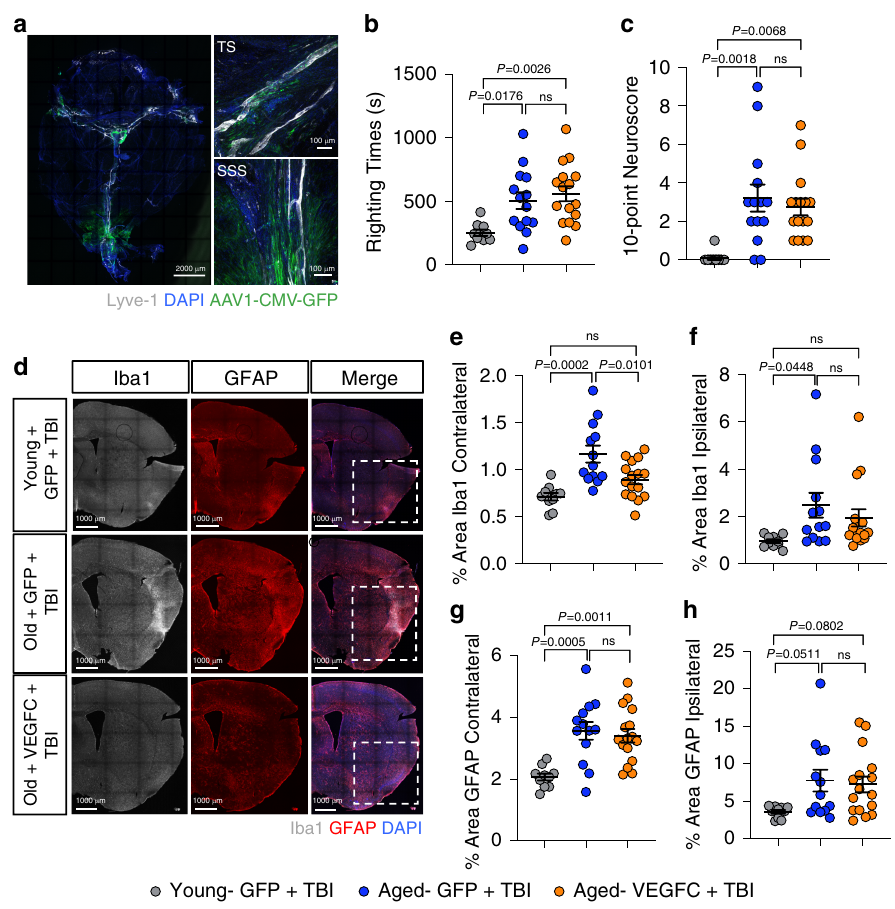
Fig. 7 VEGF-C treatment of aged mice results in decreased neuroin fl ammation after TBI. Aged mice (18 – 20 months old) received 2 μ l of arti fi cial CSF containing 10 13 genome copies per ml of either AAV1-CMV-mVEGF-C or control AAV1-CMV-eGFP by i.c.m. injection to rejuvenate meningeal